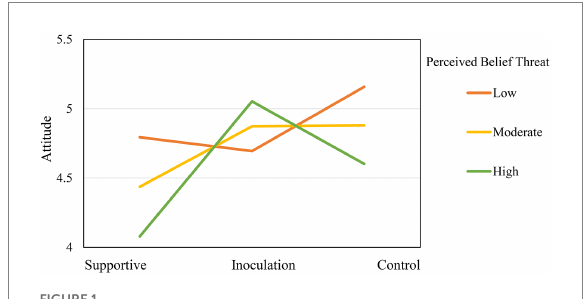
FIGURE 1 The moderating effect of perceived belief threat among the three groups.